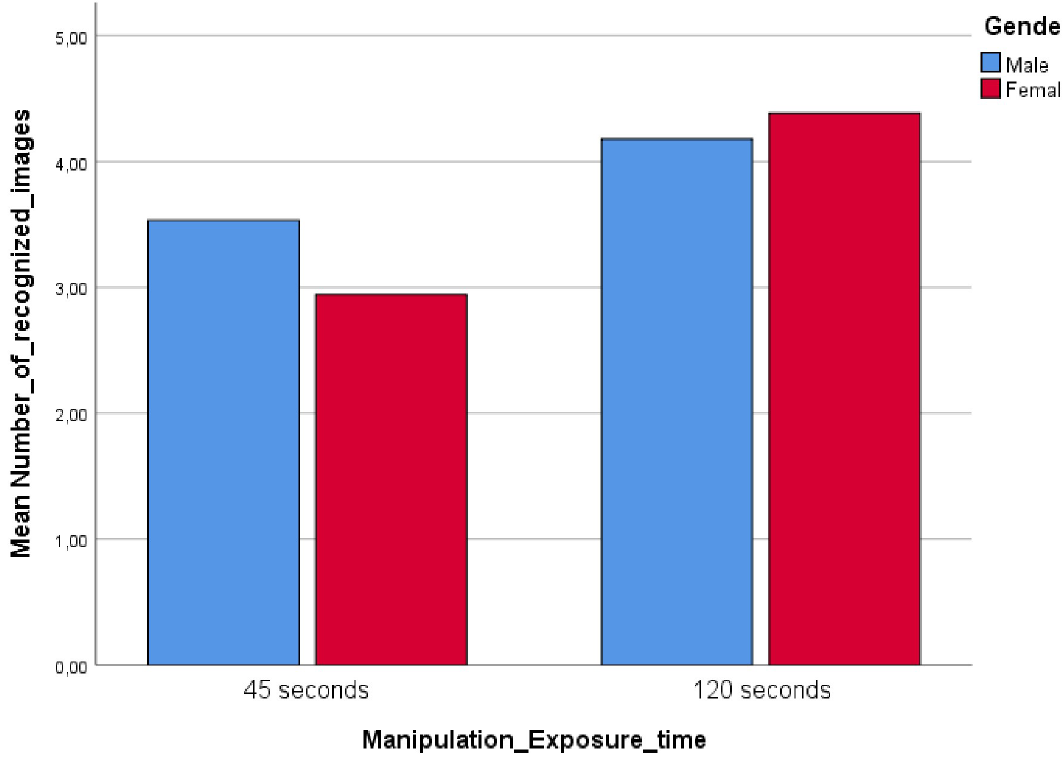
Fig 1. Study 1: Interaction between exposure time and